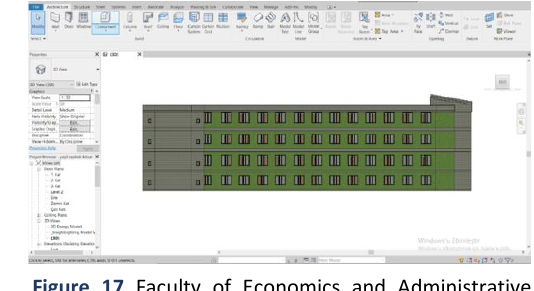
Figure 16 Faculty of Economics and Administrative Sciences Block A Building South Facade View with Vertical Green System Applied